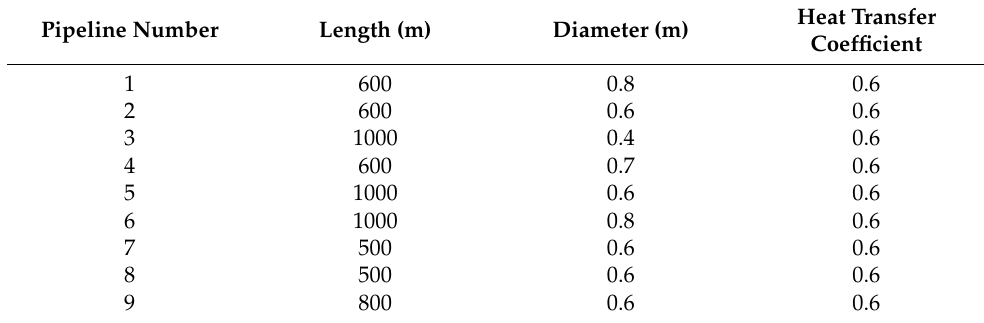
Table A2. Pipeline parameters of the nine-node double-heat-source ring steam heating network.